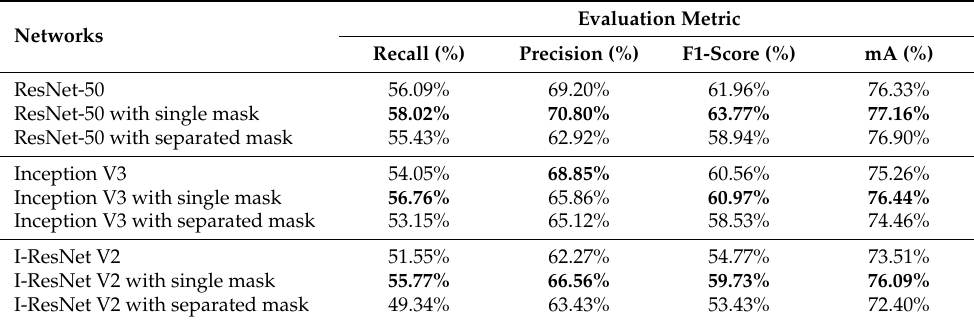
Table 5. Ablation study for the proposed method on PETA dataset.